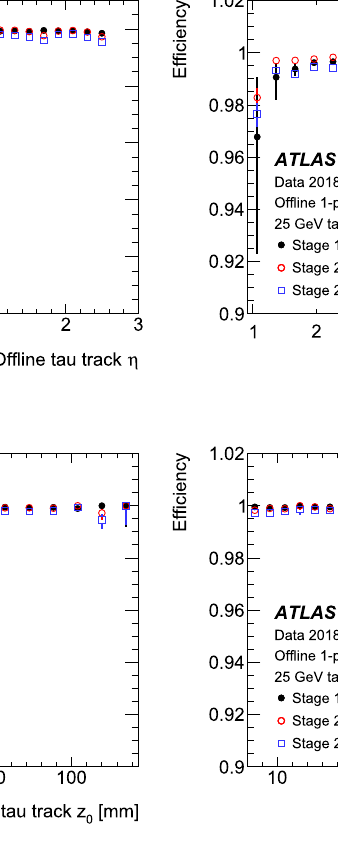
b offline track p T , c offline track z 0 and d mean number of interactions per bunch crossing. Statistical Bayesian uncertainties are shown, using a 68.3% confidence interval and uniform beta function